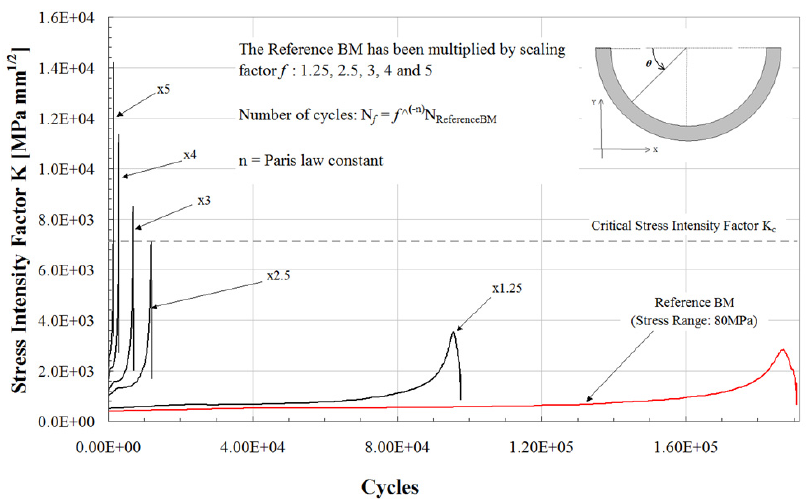
Figure 30: Variation of K with cycles for different load cases